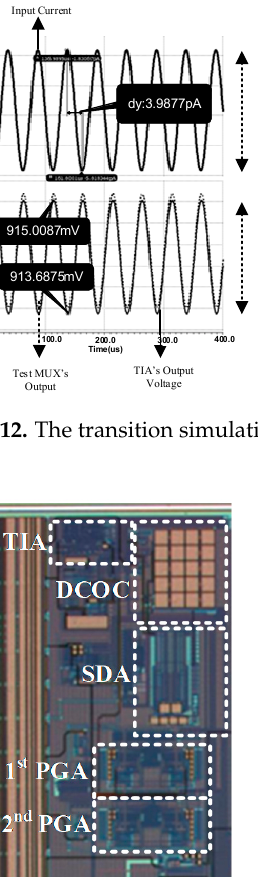
Figure 11. Monte-Carlo analysis for the total input-referred noise.